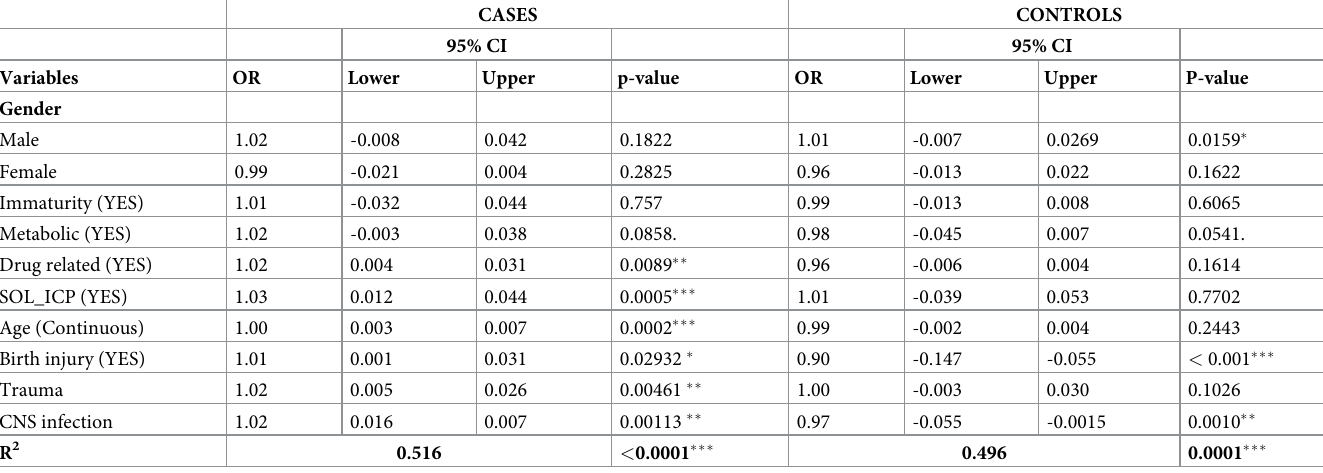
Table 2. The most influential drivers of brain atrophy among children. The multiple logistic regression analysis show none of the demographic factor as a significant variable in causing brain atrophy. The order of influence and significance is represented by space occupying lesions, central nervous system infection, convulsions and anti-epileptic drugs, and birth